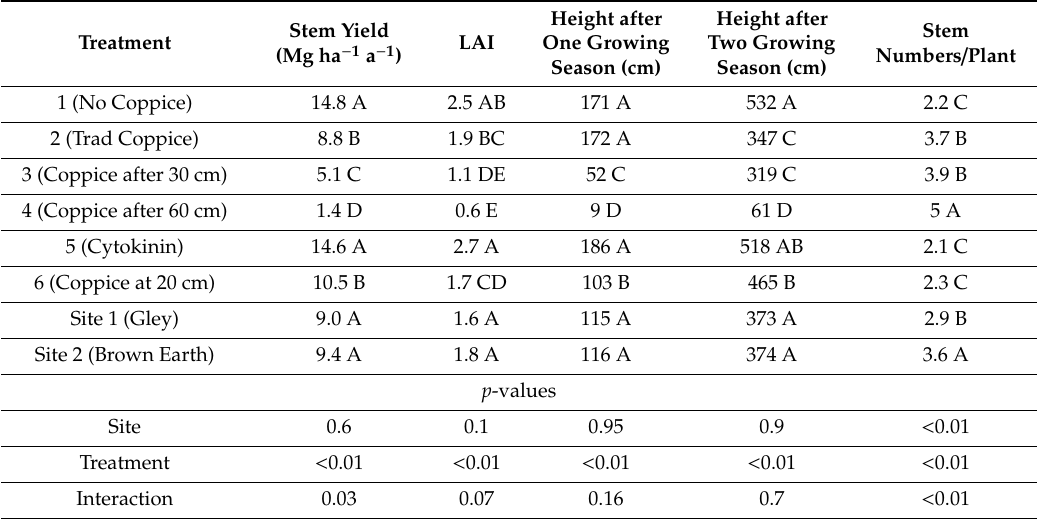
Table 6. Stem yield (represented as dry matter tonnes per hectare measured after two growing seasons).